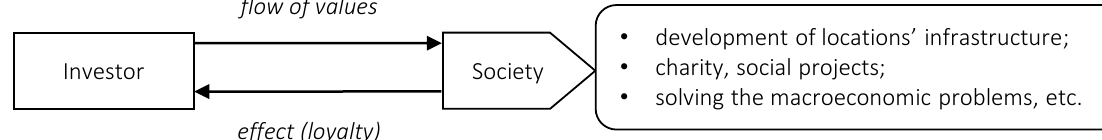
Figure 4. Process of social result formation under the influence of